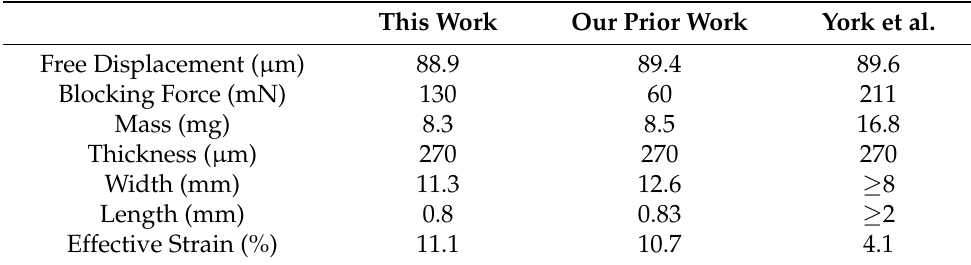
Table 2. Performance factors comparison for equivalent active